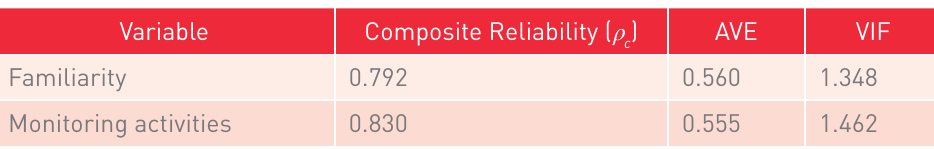
Reliability test